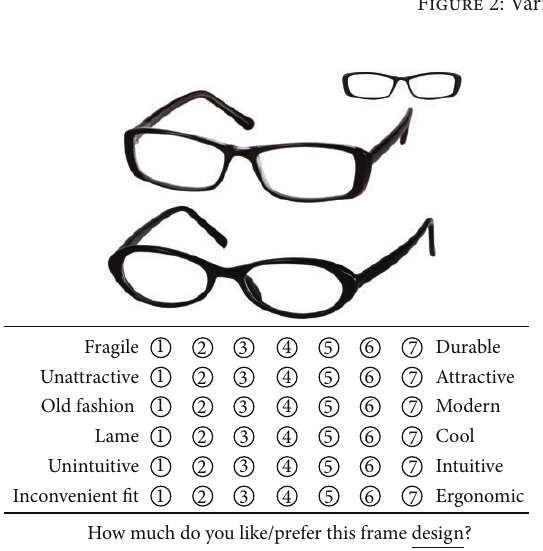
Figure 2: Variant design of spectacles.